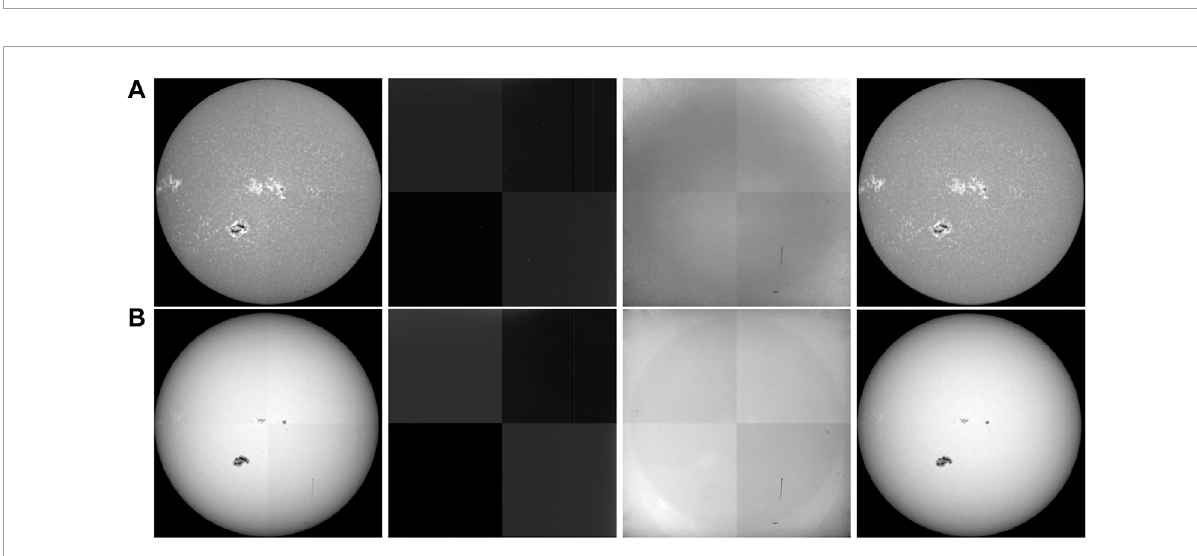
FIGURE 6 Examples of the raw and calibrated Ca II K (A) and blue continuum (B) observations obtained on 14th January 2005, and relative calibration data. From left to right in each row: raw image, dark frame, flat-field response, and calibrated image. The quadrant pattern in raw observations and calibration data generated by the four amplifiers of the recording camera is accurately compensated for in the calibrated observations, as are the small-scale dark structures in the raw observations and flat-field images produced by permanent inhomogeneities of the substrate of the detector and occasional dust and hairs on